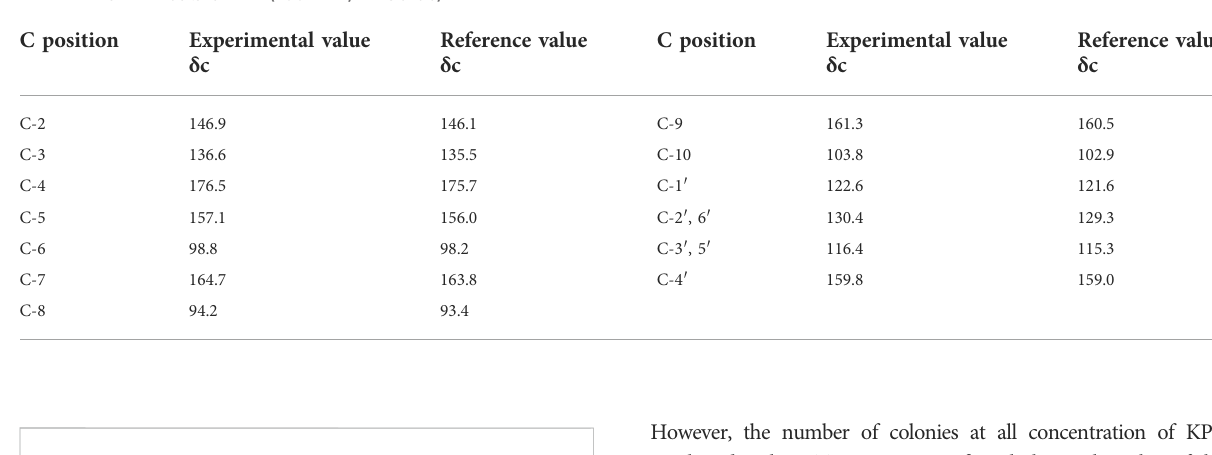
TABLE 1 13 C NMR data of KPL (100 MHz, DMSO d6).